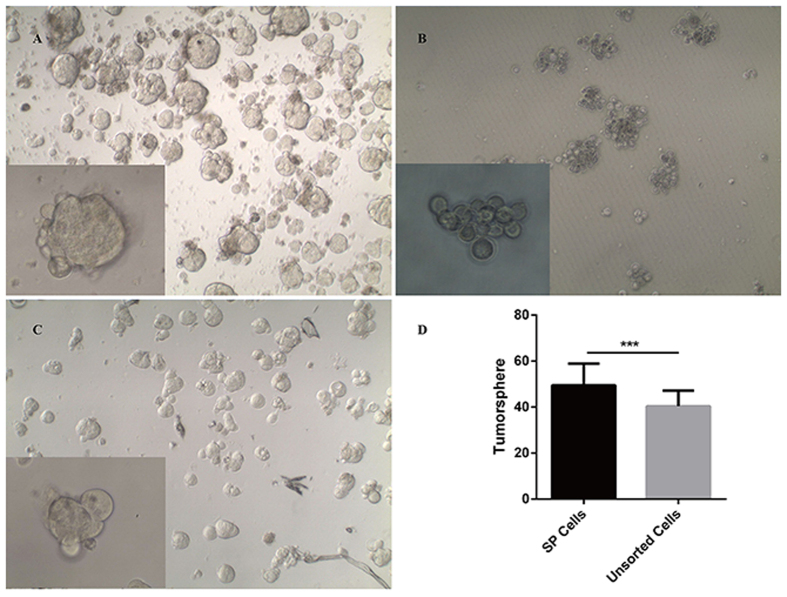
Tumorsphere cultures of SP, NSP and unsorted cells in serum-free medium.9 days after seeded into 6-well ultra-low attachment plates in the serum-free medium, SP, NSP and unsorted cells (SP/NSP cells were sorted from freshly isolated HCC tissues) showed different abilities to form tumorspheres. (A) SP cells could form tumorspheres. (B) NSP cells could not form tumorspheres. Actually most of the NSP cells could not survive after such a long time serum-free medium culture, and the remaining cells were connected loosely and could be blowed into single cells easily. (C) Unsorted cells could form tumorspheres. (D) Tumorspheres from SP cells were significantly more than that from unsorted cells (49.48 ± 9.44 vs. 40.37 ± 6.48, F = 5.46, P < 0.05, n = 6).